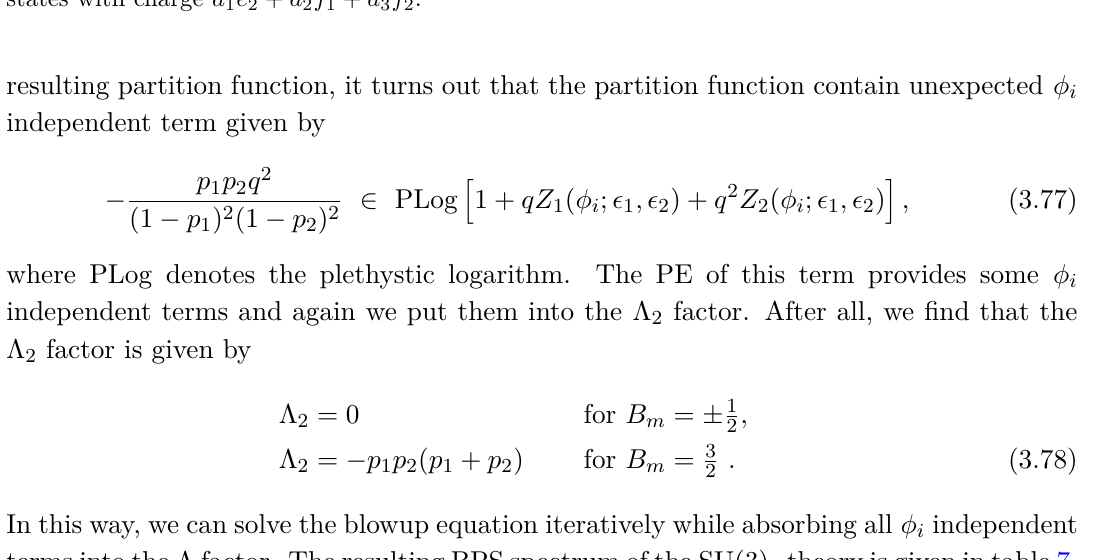
Table 6. BPS spectrum of SU(3) 5 for d 1 ≤ 3 and d 2 , d 3 ≤ 2 . Here, d = ( d 1 , d 2 , d 3 ) labels the BPS states with charge d 1 e 2 + d 2 f 1 + d 3 f 2